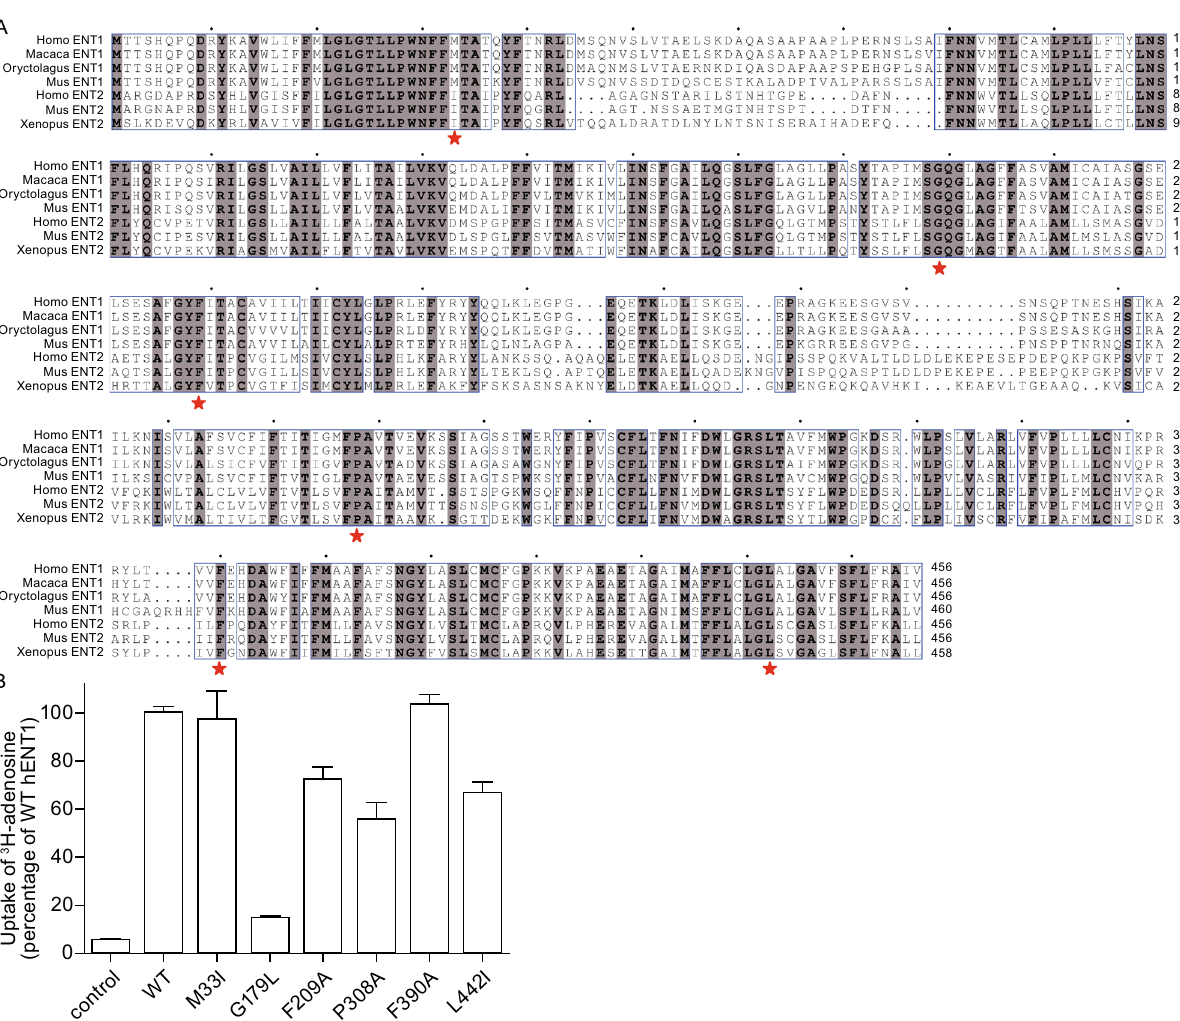
the mutation of Gly179 to Leu (G179L) led to 90 percent reduction of the transport activity for adenosine (Fig. 6B). Four additional mutations, each involving a conserved hydrophobic residue, had different impacts on the transport activity of hENT1. No signi fi cant difference ( P = 0.2469) was detected in the ability of adenosine transport for F390A (Fig. 6B). While compared to WT protein, mutations F209A ( P < 0.01), P308A ( P < 0.001), and L442I ( P < 0.001) exhibited signi fi cantly reduced adenosine uptake activity